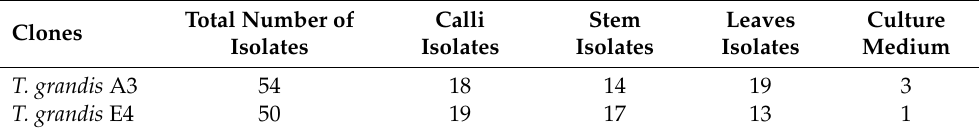
Table 1. Number of bacteria isolates from T. grandis tissues of clones A3 and E4. Clones